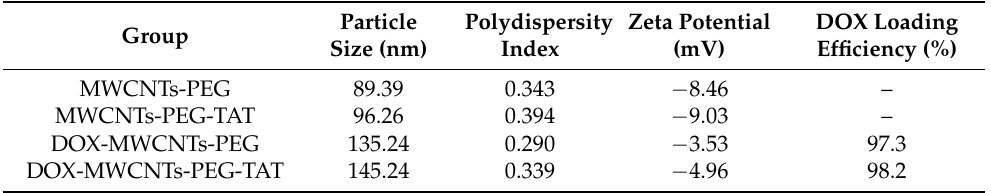
Table 3. Physiochemical characterization of different MWCNTs complexes. Reproduced with permis- sion from [205]. Particle Polydispersity Zeta Potential DOX Loading Group Size (nm) Index (mV) Efficiency (%) MWCNTs-PEG 89.39 0.343 − 8.46 – MWCNTs-PEG-TAT 96.26 0.394 − 9.03 – DOX-MWCNTs-PEG 135.24 0.290 − 3.53 97.3 DOX-MWCNTs-PEG-TAT 145.24